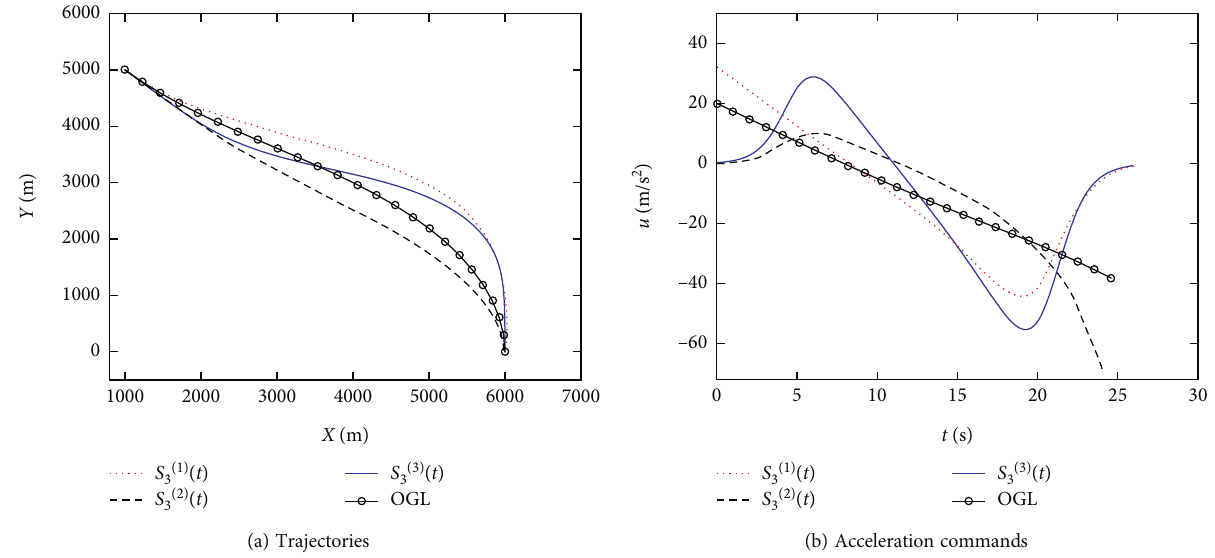
ð 0 Þ = − 45 ° , γ = − 90 ° . m f